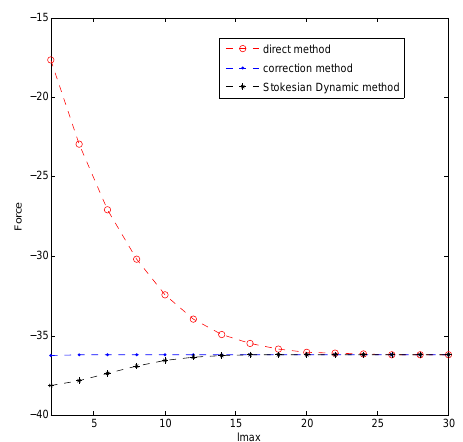
Fig. 7: Forces on the particle B 2 in z direction com- puted with the three methods with d = 0 . 05 .